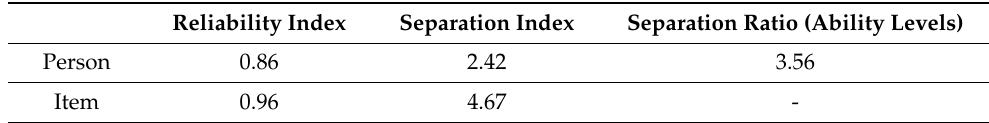
Table 5. INSPECT Person and Item Reliability and Separation